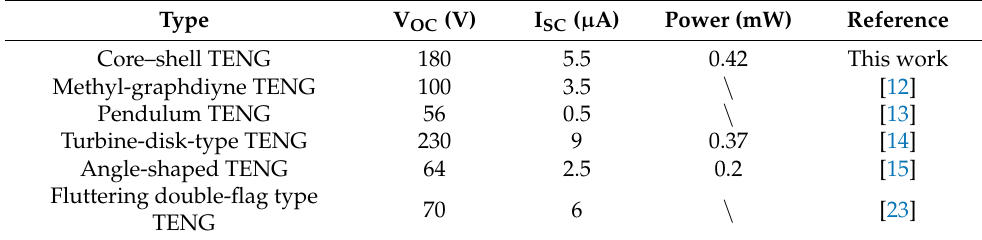
Figure 5. ( a ) V OC of the CS-TENG at different wind speeds. ( b ) Charging performance at different wind speeds. ( c ) Charging and discharging processes of a capacitor to power a miniature calculator. ( d ) Prospect applications of the CS-TENG. ( e ) Photograph of the CS-TENG powering light-emitting diodes (LEDs). ( f ) Photograph of the self-powered pH test system. Table 1. Performance of CS-TENG and the reported wind-harvesting